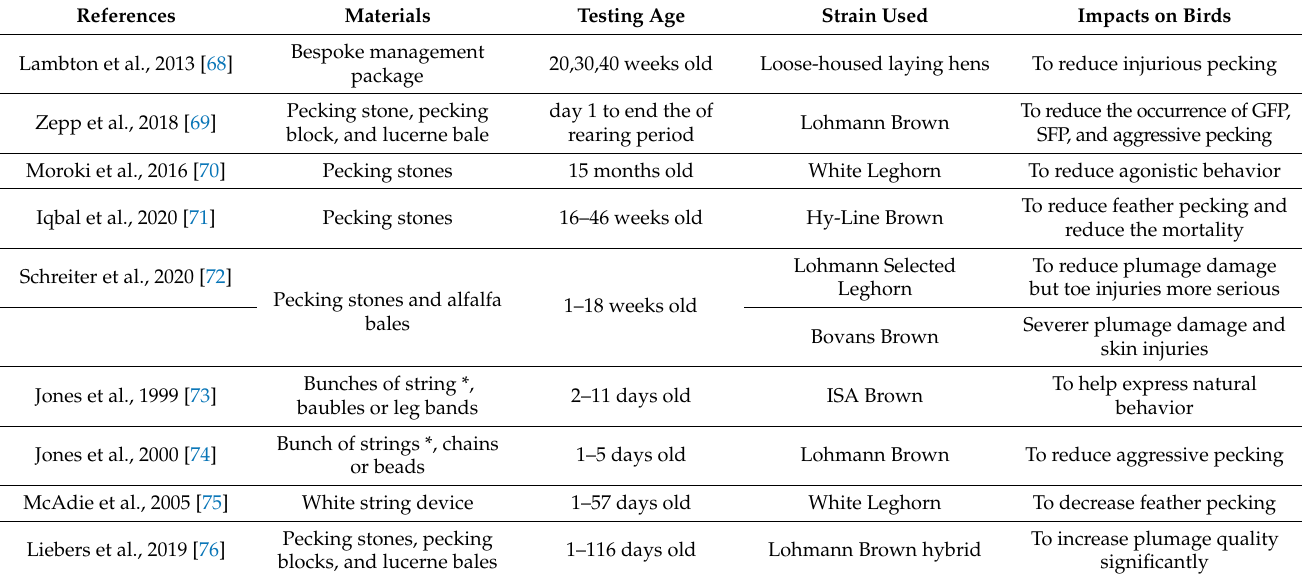
Table 2. Pecking materials designed for layers used in different